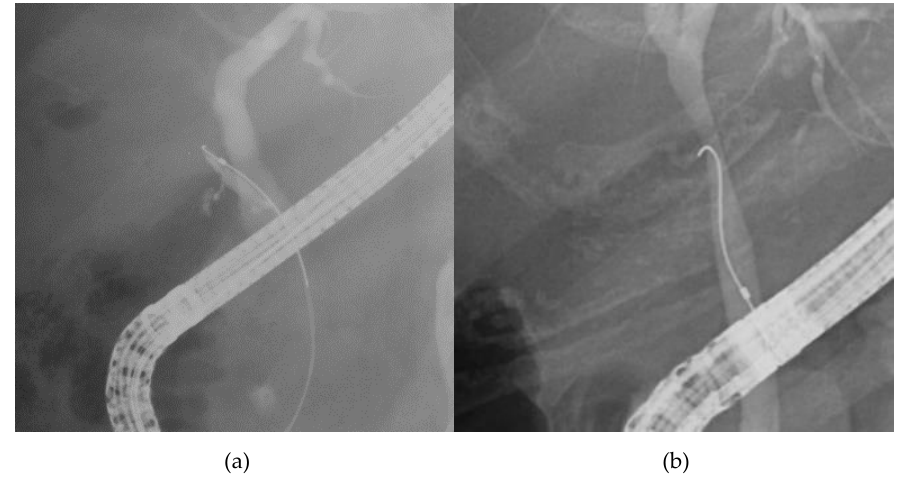
Figure 6. Cholangiography image of cranial branch and caudal branch; ( a ): cranial branch, ( b ): caudal